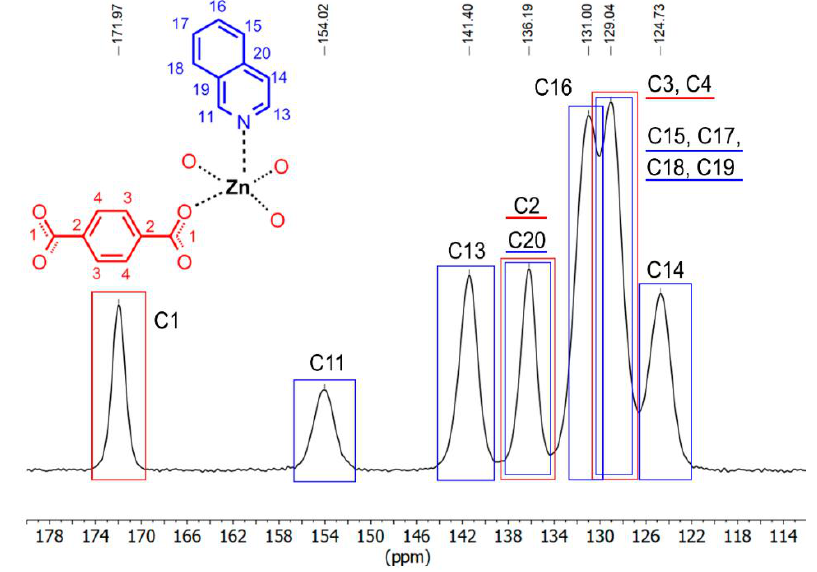
Figure 6. 13 C CPMAS NMR spectrum for 1 and numbering scheme of the building unit. Regions with rotation side bands at 8 (16) kHz = 64 (128) ppm from the signal are covered in the NMR spectrum.